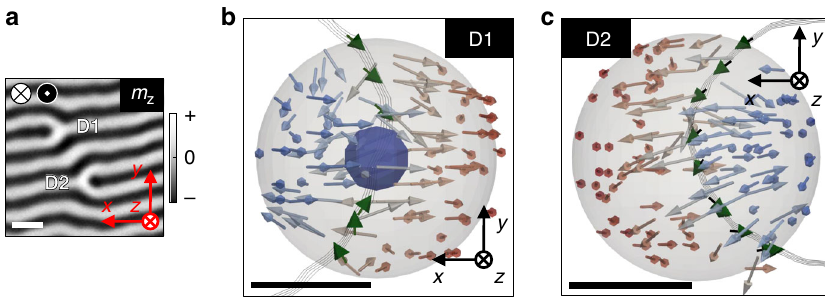
Fig. 3 Tomographic reconstruction of magnetic singularities. a Out-of-plane ( m z ) component from the joint reconstruction of Tilt series 1 and 2 at the central slice of the volume model. Dislocations D1 and D2 are indicated. Gray scale bar indicates the sign of m z . b , c 3D representation of the magnetic textures at the cores of D1 ( b ) and D2 ( c ). Arrows depict the orientation of the magnetization colored with Blue-White-Red indicating Negative-Zero- Positive sign of m z . Green arrows show the magnetization within the Bloch domain-wall at the core of the dislocations. Blue sphere marks the Bloch-point singularity. Scale bar a 525 nm, b 75 nm, c 105 nm.